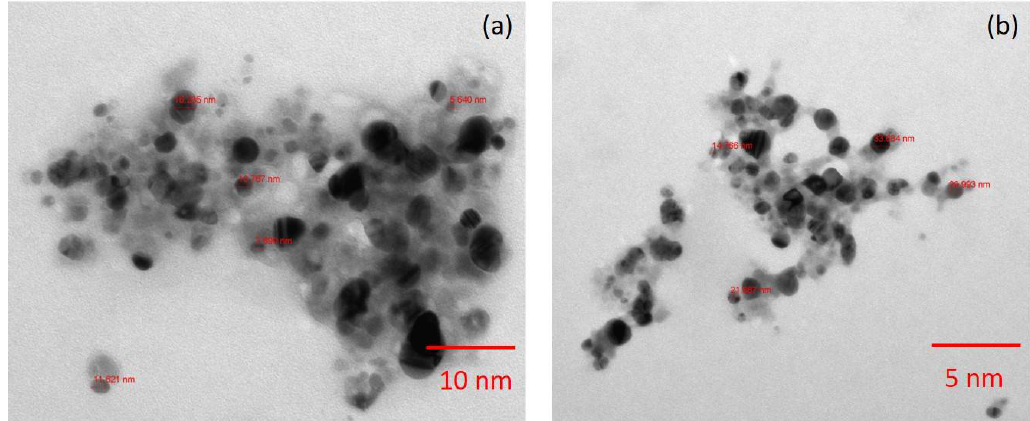
Figure 4. The transmission electron microscope (TEM) image of the silver nanoparticles derived from marine Streptomyces sp. Al-Dhabi-87. ( a ) TEM at 10 nm scale ( b ) TEM at 4 nm scale.